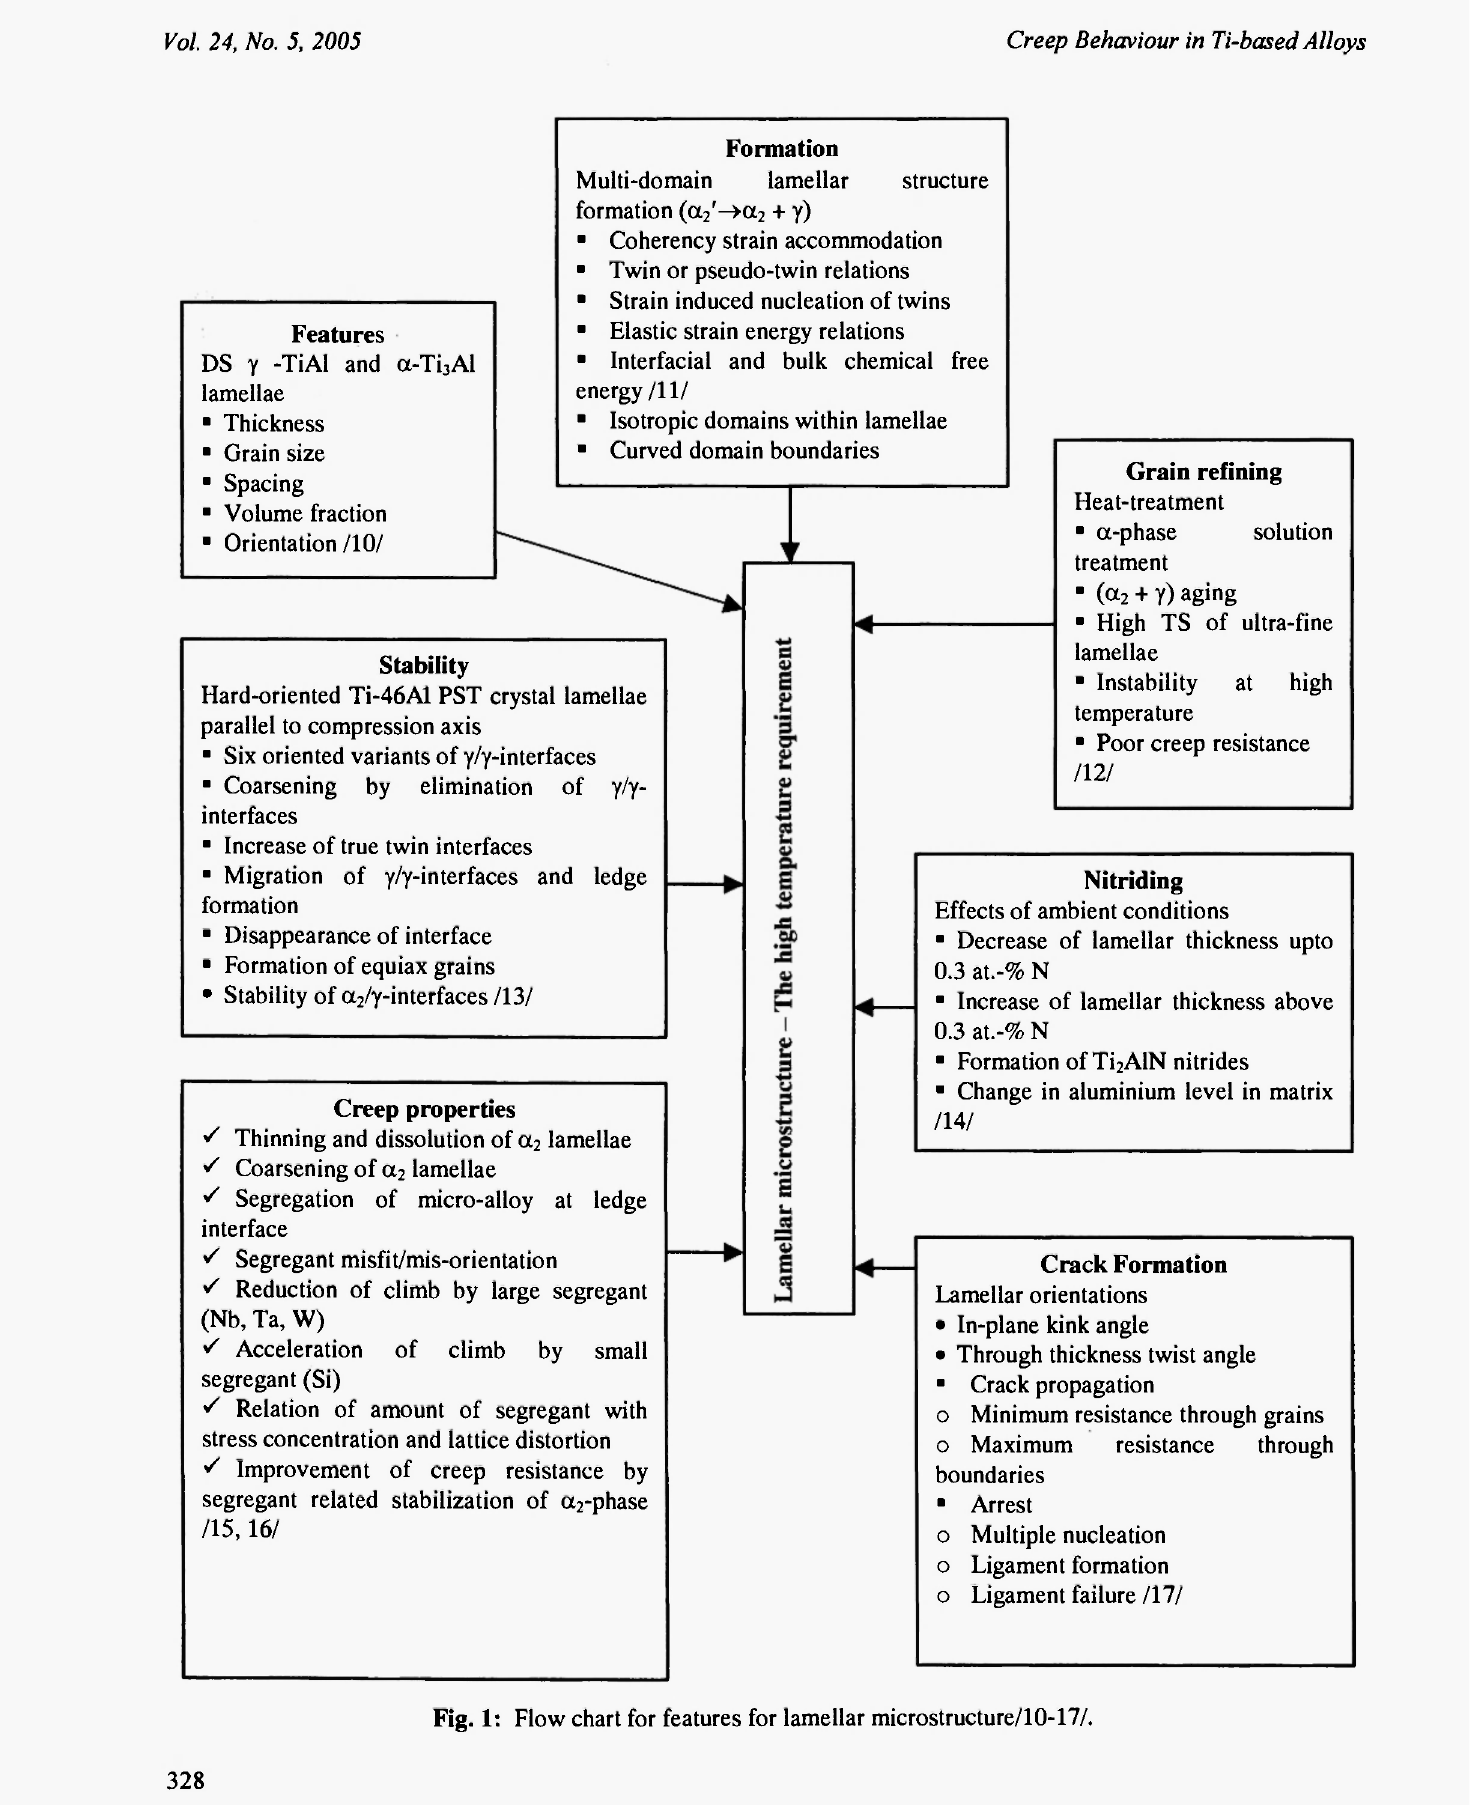
Fig. 1: Flow chart for features for lamellar